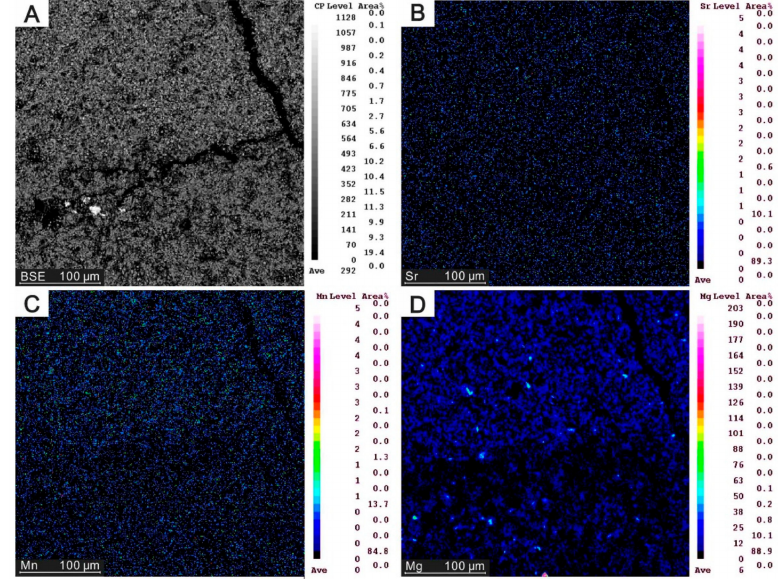
Figure 3. Back-scattered electron (BSE) image ( A ) and electron microprobe element maps ( B – D ) of a selected area of D1S2 carbonate, revealing homogeneous distribution of Sr, Mn, and